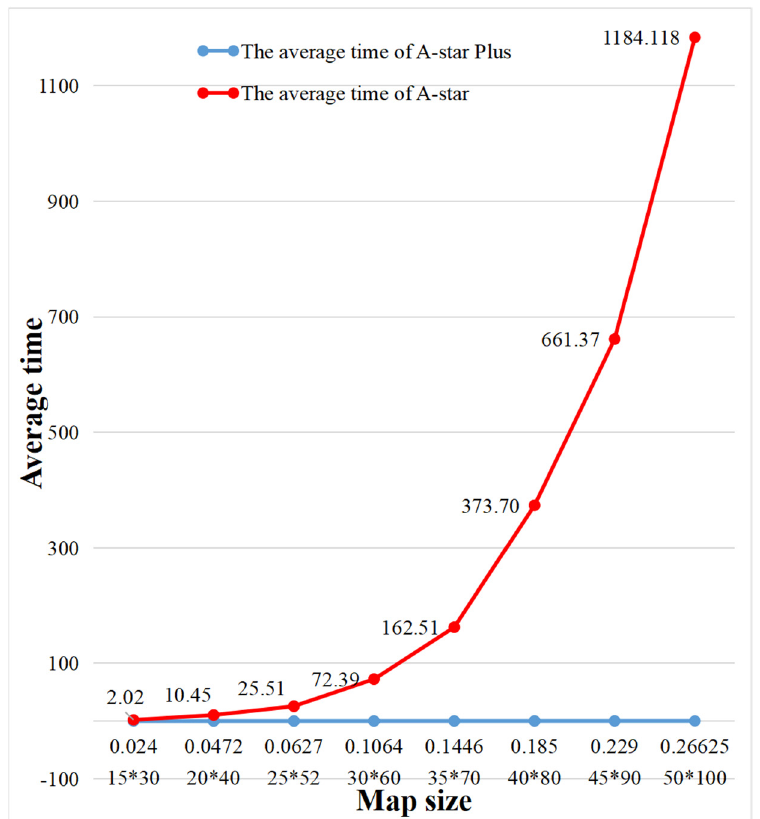
Figure 12. Comparison of explore node between A-star algorithm and A-star Plus algorithm.